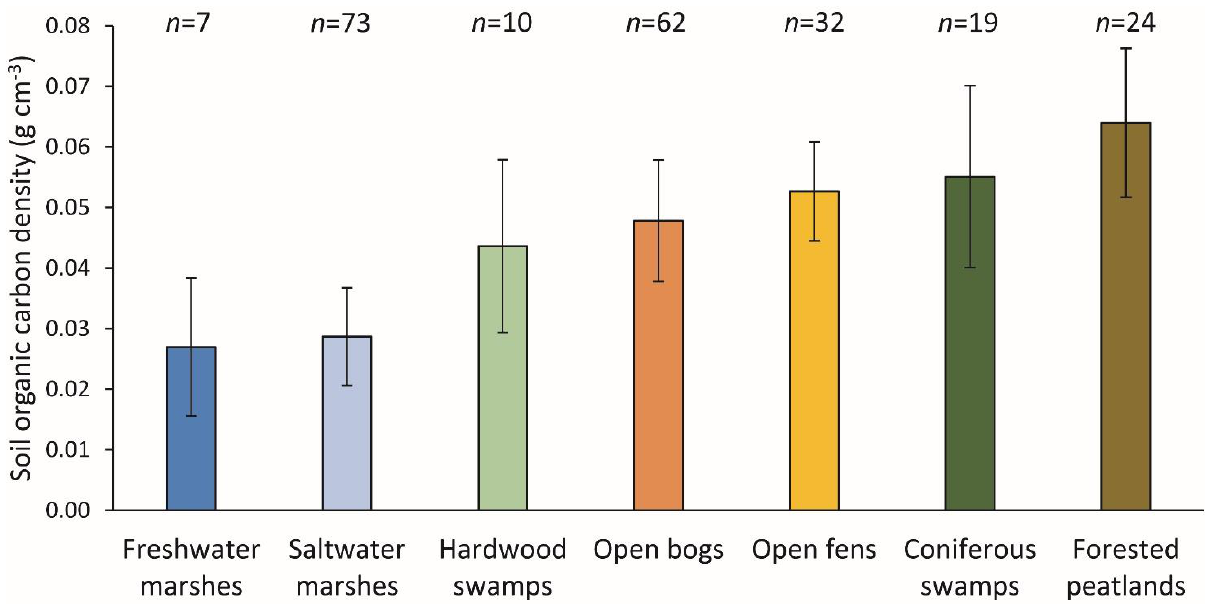
Figure 3. Mean SOC densities (± SD) for the different wetland subclasses from eastern Canada. The number of peat/soil cores included in the calculation of the mean is indicated for each wetland